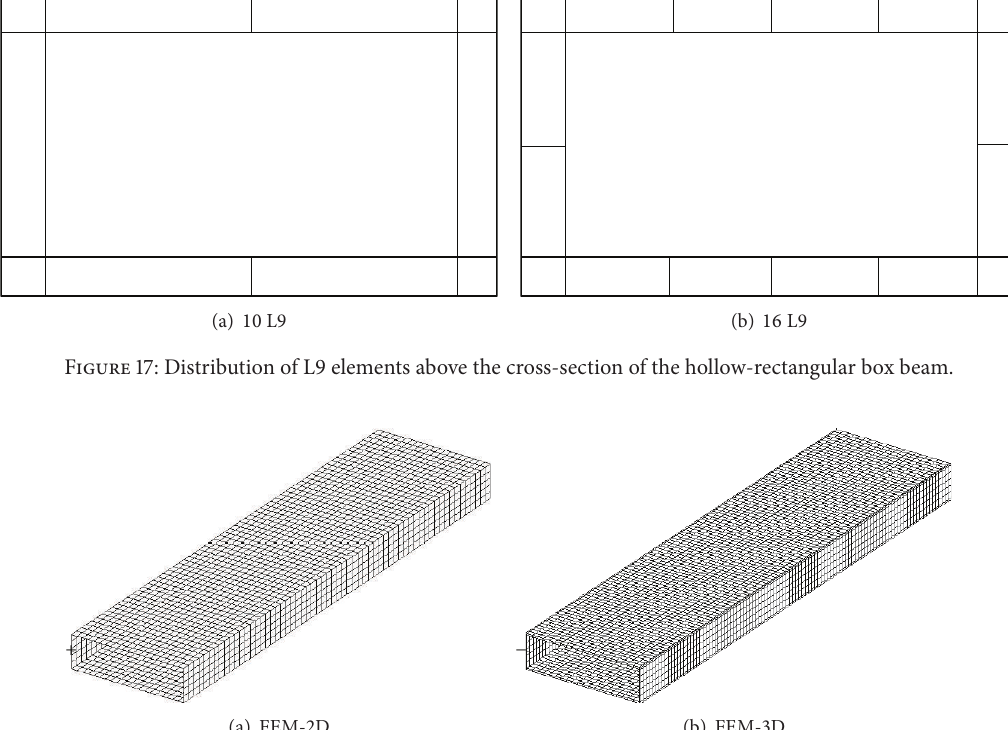
data were as follows: 𝑏 = 0.5 m, 𝑎 = ℎ = 2𝑏 , and 𝑡 = 0.1